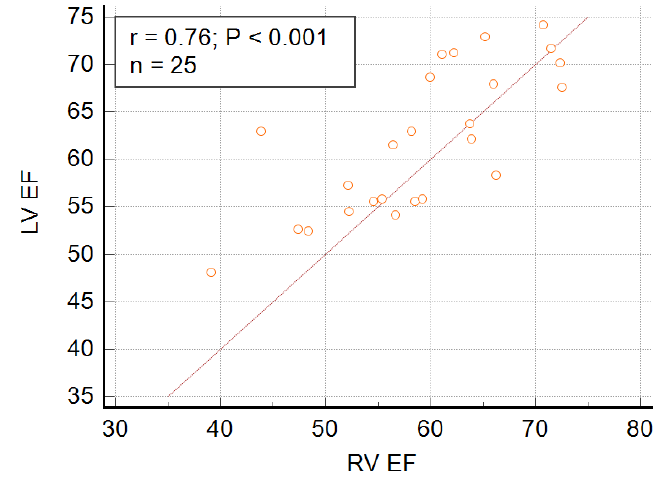
Figure 1. Correlation between RVEF and LVEF.